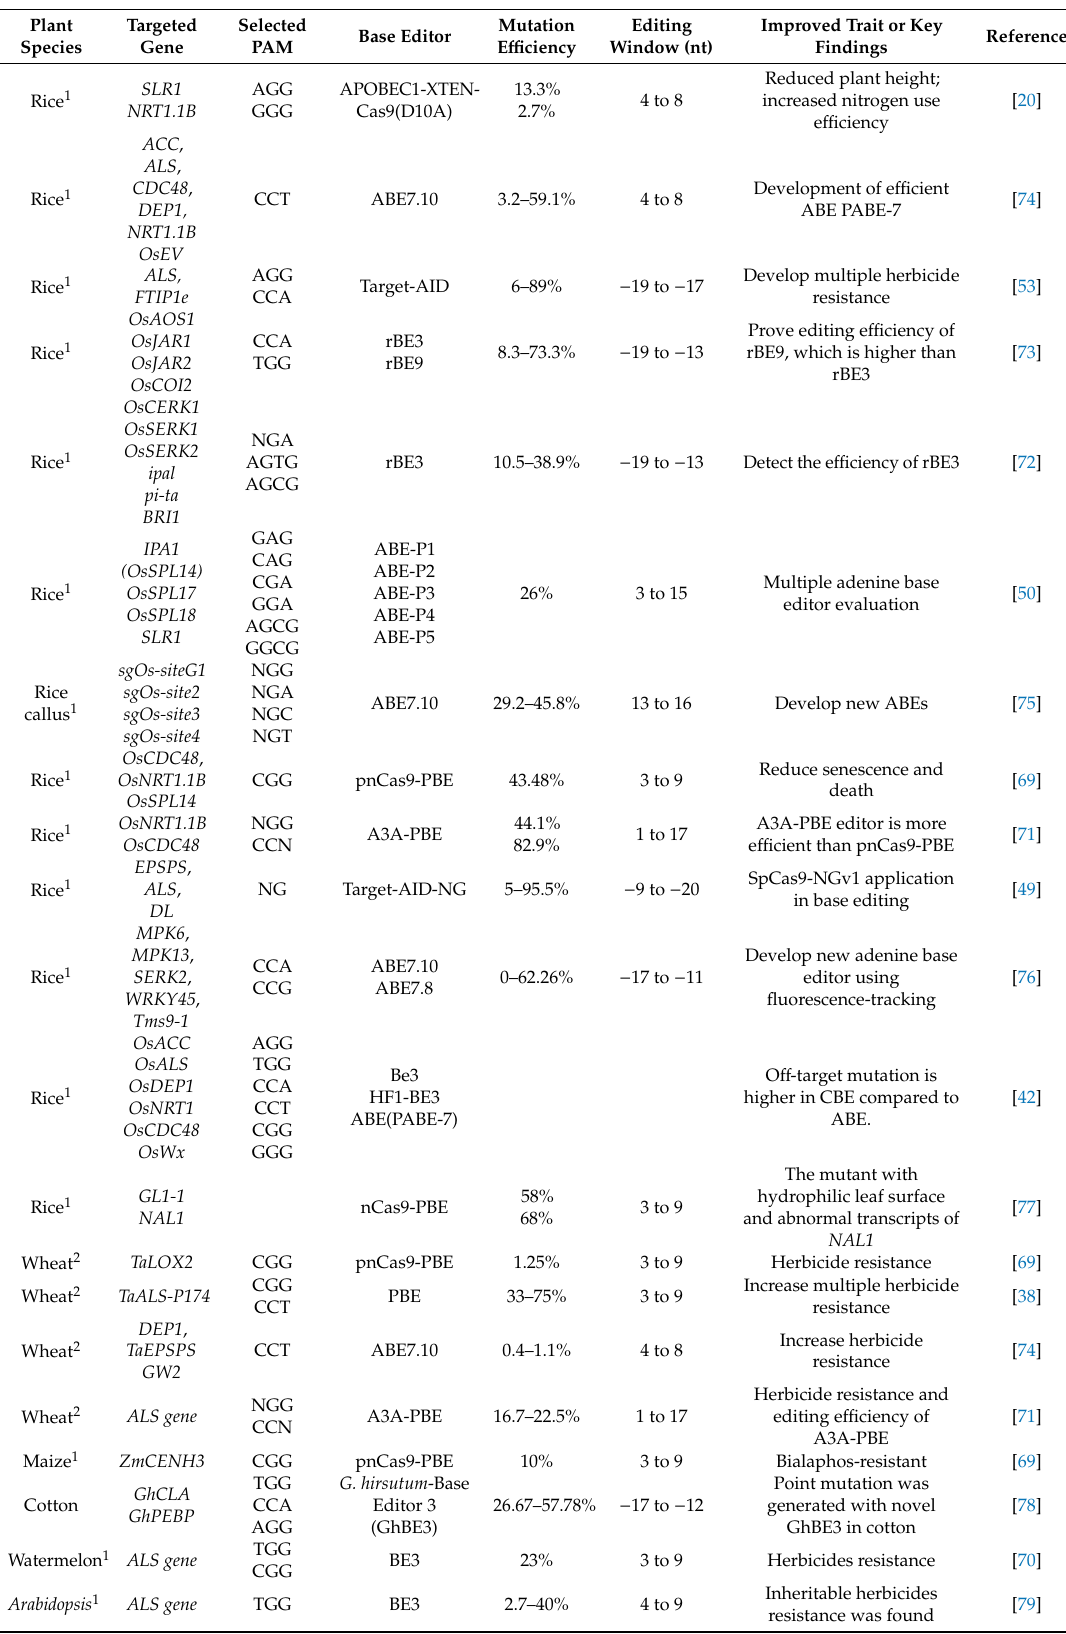
Table 1. Application of base editing in di ff erent plant